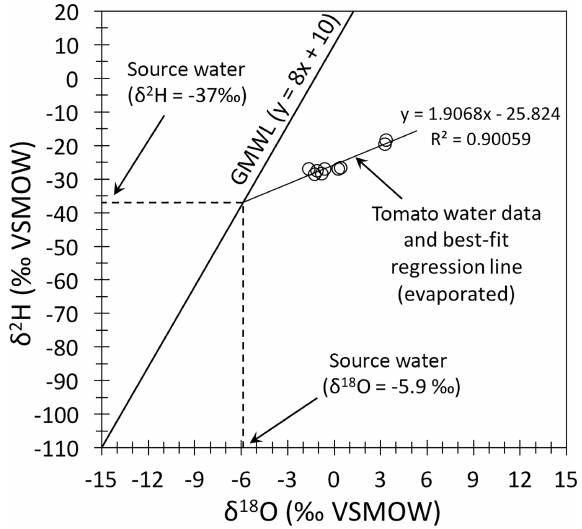
Figure 4. Graphical method of fruit source water determination by back-projecting regression line through δ 2 H liq and δ 18 O liq values of water inside tomatoes (open symbols) to find the source water δ 2 H liq and δ 18 O liq values.